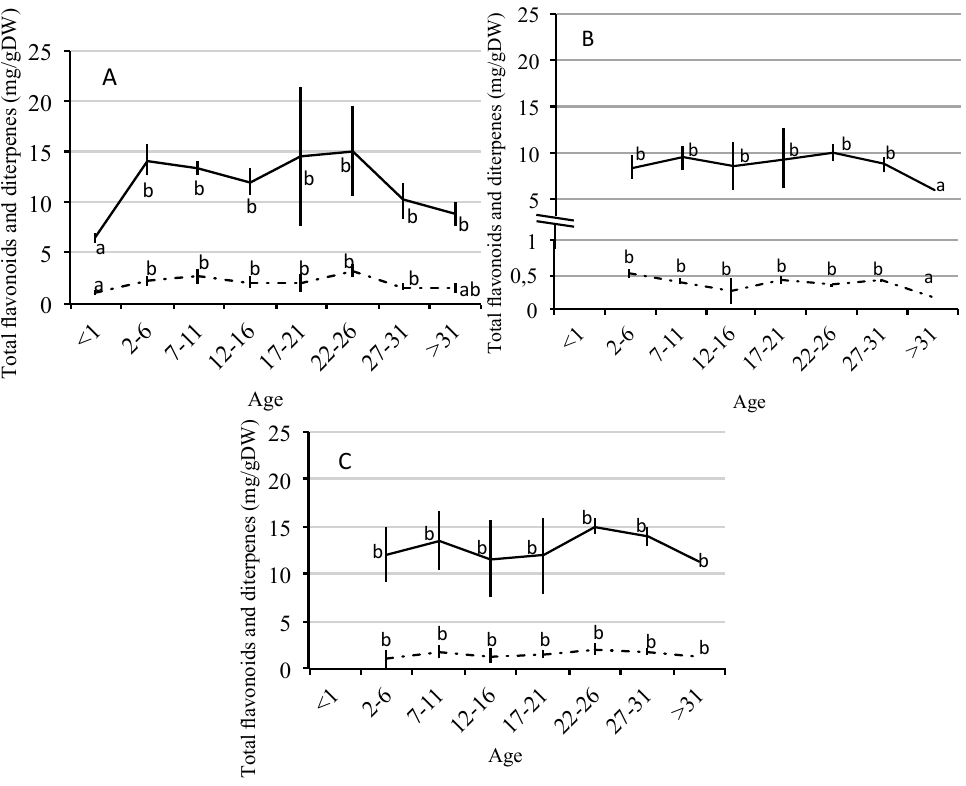
Figure 4. Total flavonoids ( ― ) and diterpenes (·-·-·-·) (mg/g dw) for different age groups in samples of young leaves ( A ); mature leaves ( B ) and stems ( C ). a, b : different letters mean significant differences between ages p < 0.05 (Wilcoxon Test).